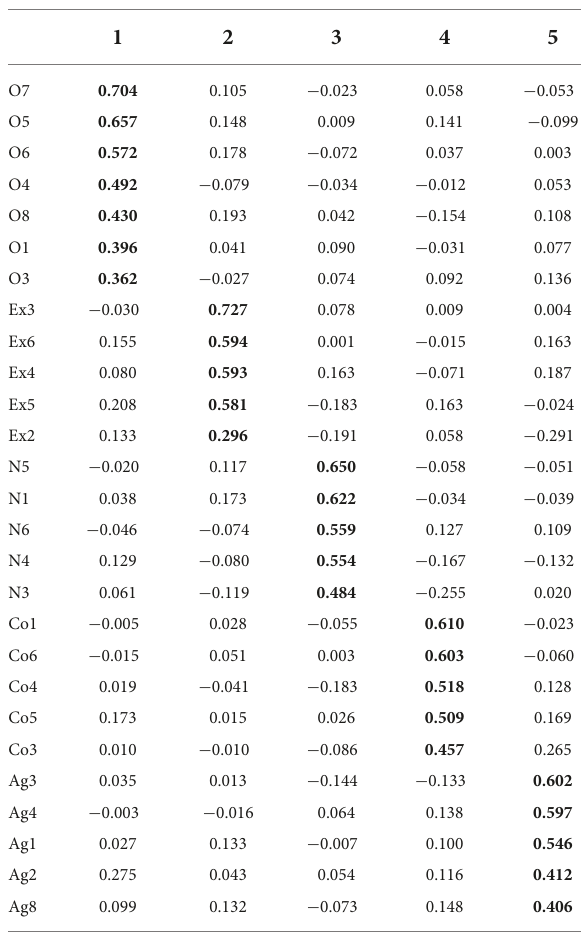
TABLE 2 A principal component solution after dropping items that do not load on targeted